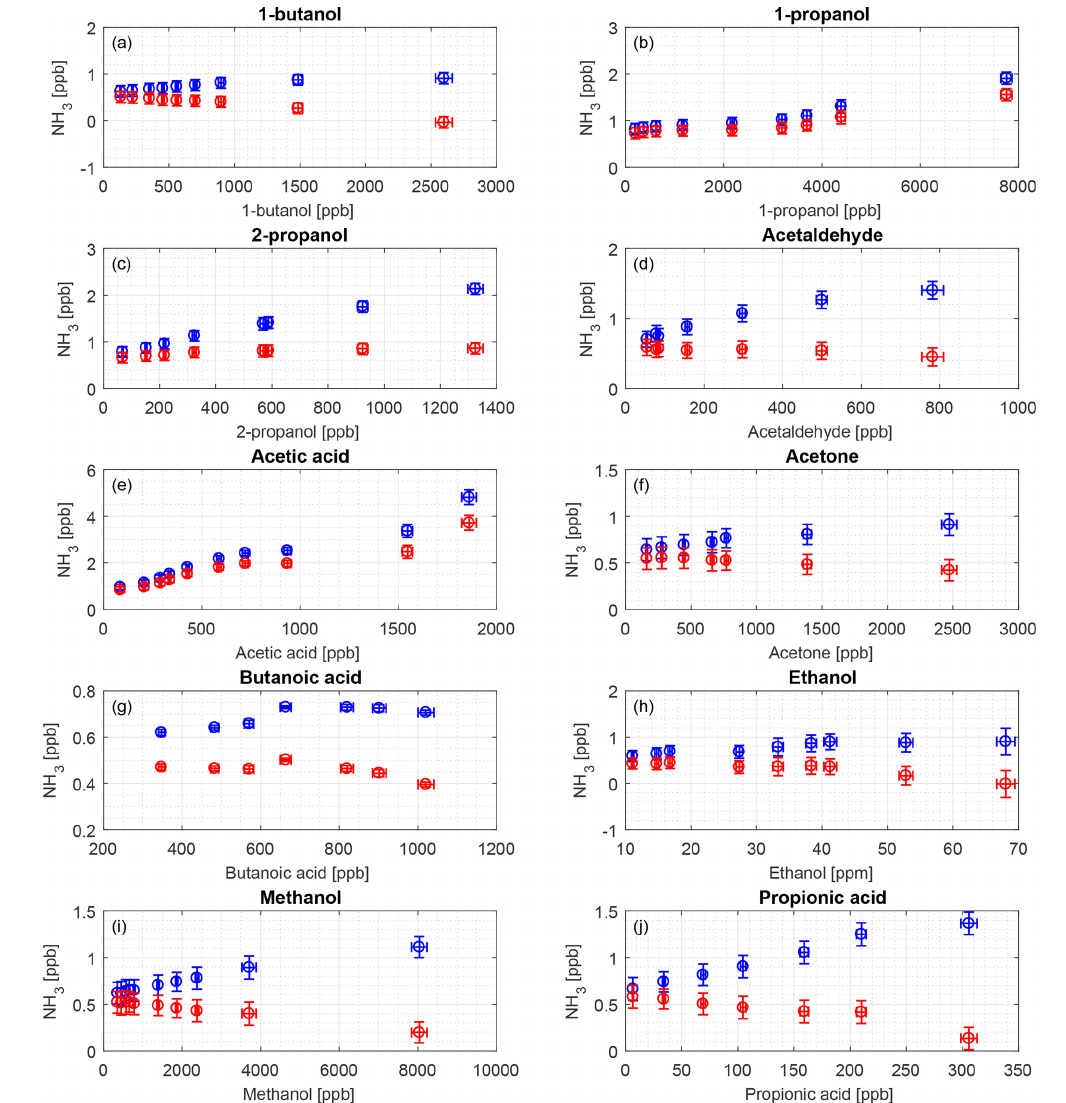
Figure 7. Interference of different organic compounds on the CRDS NH 3 measurement. Blue markers indicate the original data and red markers indicate water-corrected data from the regression shown in Fig. 5. The compounds are (a) 1-butanol, (b) 1-propanol, (c) 2-propanol, (d) acetaldehyde, (e) acetic acid, (f) acetone, (g) butanoic acid, (h) ethanol, (i) methanol, and (j) propionic